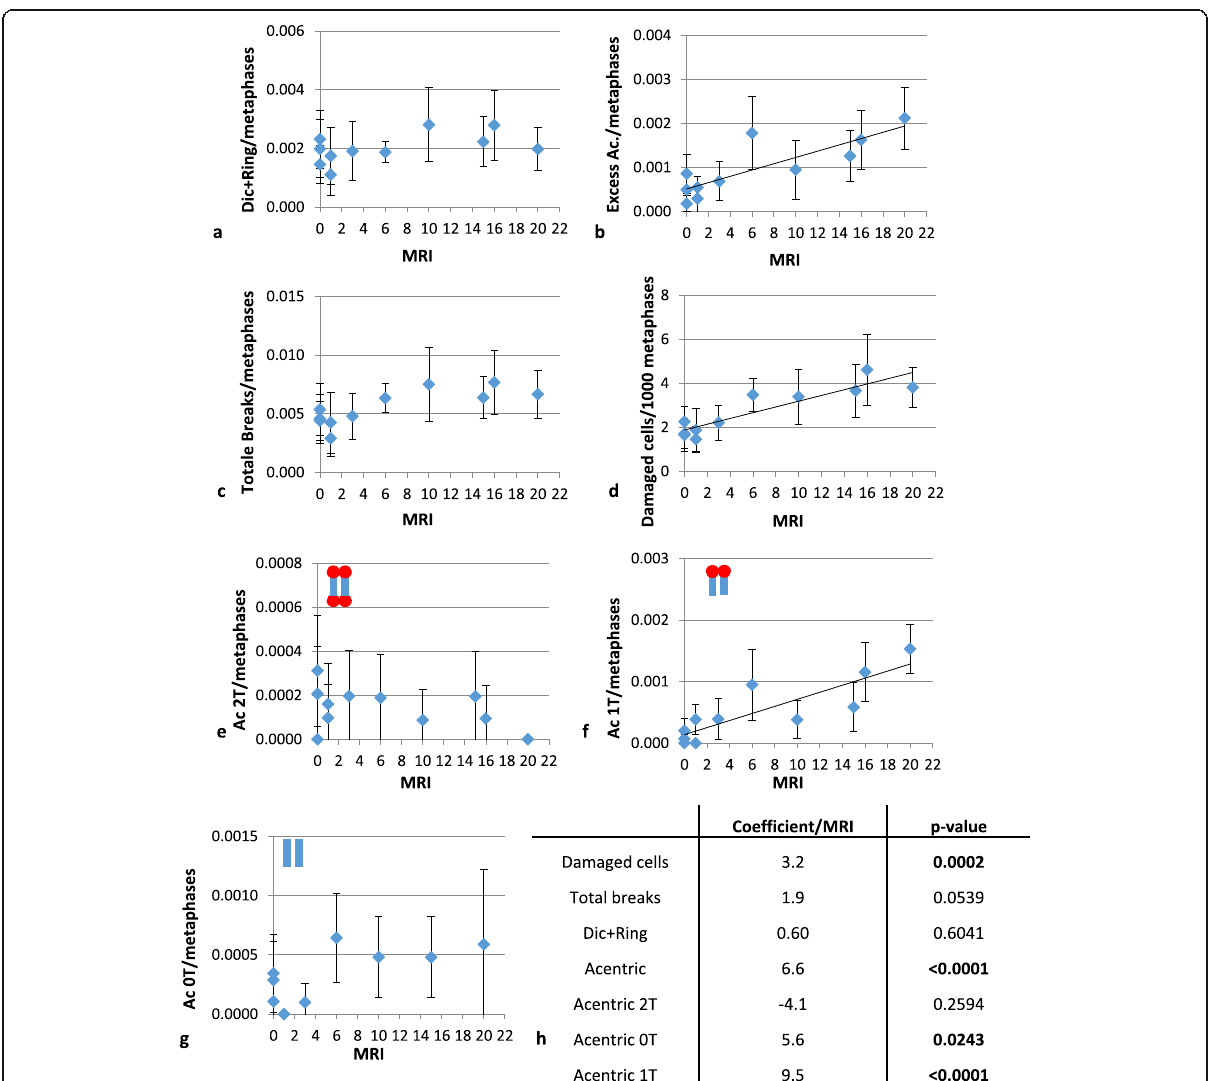
Fig. 2 Increasing chromosomal instability due to terminal deletions during the first 20 MRI sessions. Between 846 and 3,357 metaphases were observed for each time point and participant after telomere/centromere staining. Various cytogenetic parameters were scored: dicentric chromosomes and rings ( a ); total type E acentrics (excess acentric fragments) ( b ), total chromosomal breaks ( c ), damaged cells ( d ), 2-T acentric fragments resulting from two chromosomal breaks and fusion ( e ), 1-T acentric fragments equivalent to a terminal deletion ( f ), and 0-T acentric fragments resulting from two chromosomal breaks in the same chromosomal arm ( g ). h Table presenting the stratified statistical analysis (correlation coefficients and p values). Ac , Acentric fragment; Dic , Dicentric chromosomes; MRI , Magnetic resonance imaging; T ,